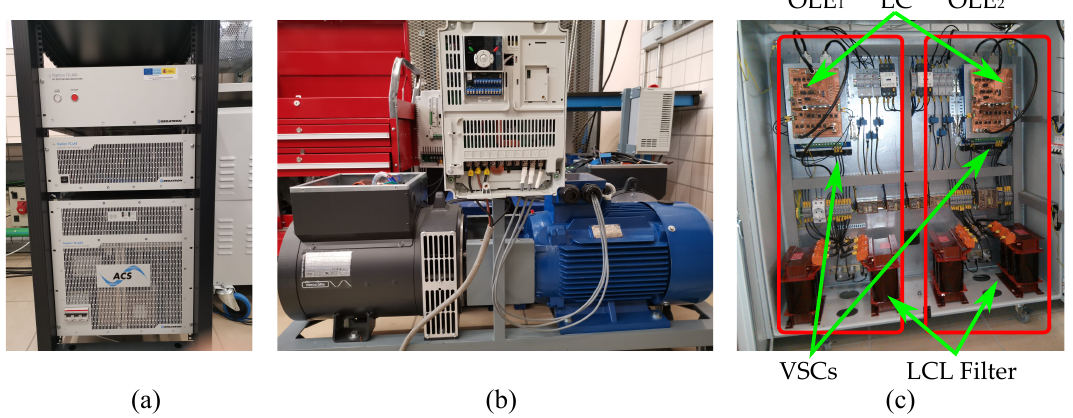
Figure 6. Elements of the PSHIL: ( a ) Regatron system, ( b ) synchronous generator, ( c ) OLEs Electrical